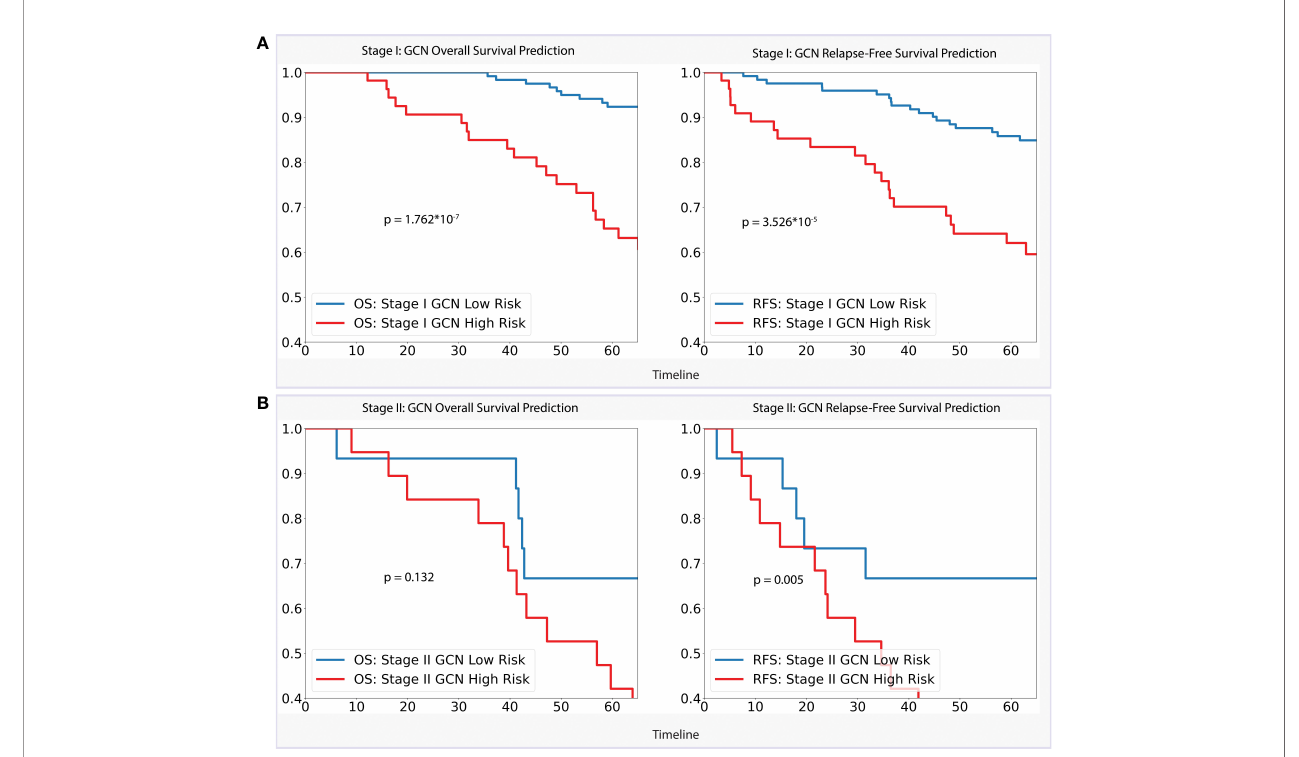
FIGURE 4 | (A) . Stage I Analysis: Performances of GCN models on OS prediction and RFS prediction separately; (B) . Stage II Analysis: Performances of GCN models on OS prediction and RFS prediction